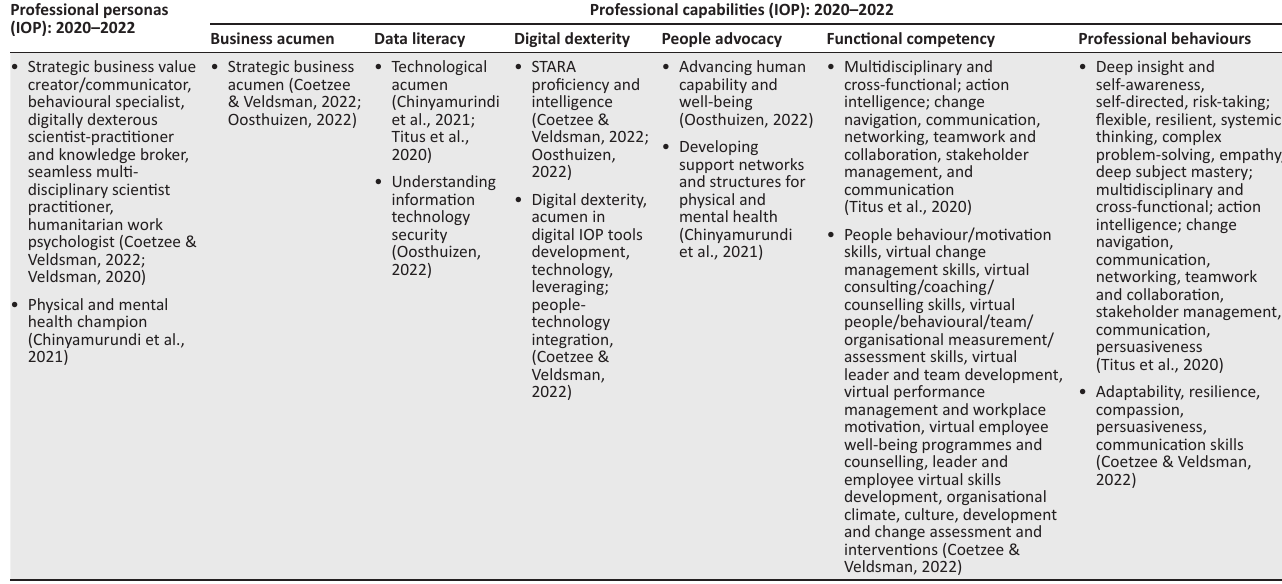
TABLE 2: Overview of professional personas and capabilities of the industrial/organisational psychologists: